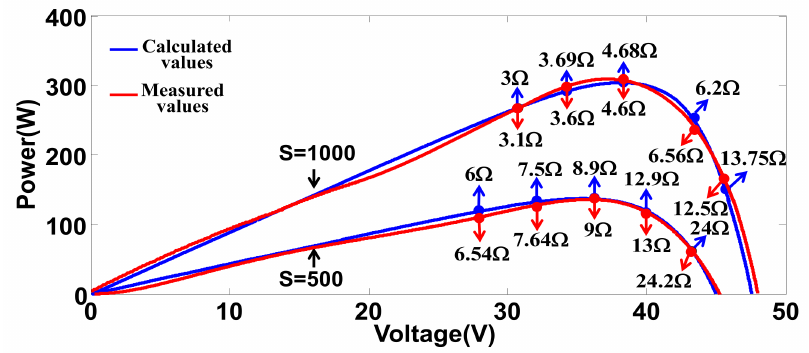
Figure 4. Comparison of calculated and measured P-V characteristics of a single PV module under 0–150 Ω load conditions and with the same irradiance conditions ( S = 1000 and 500).